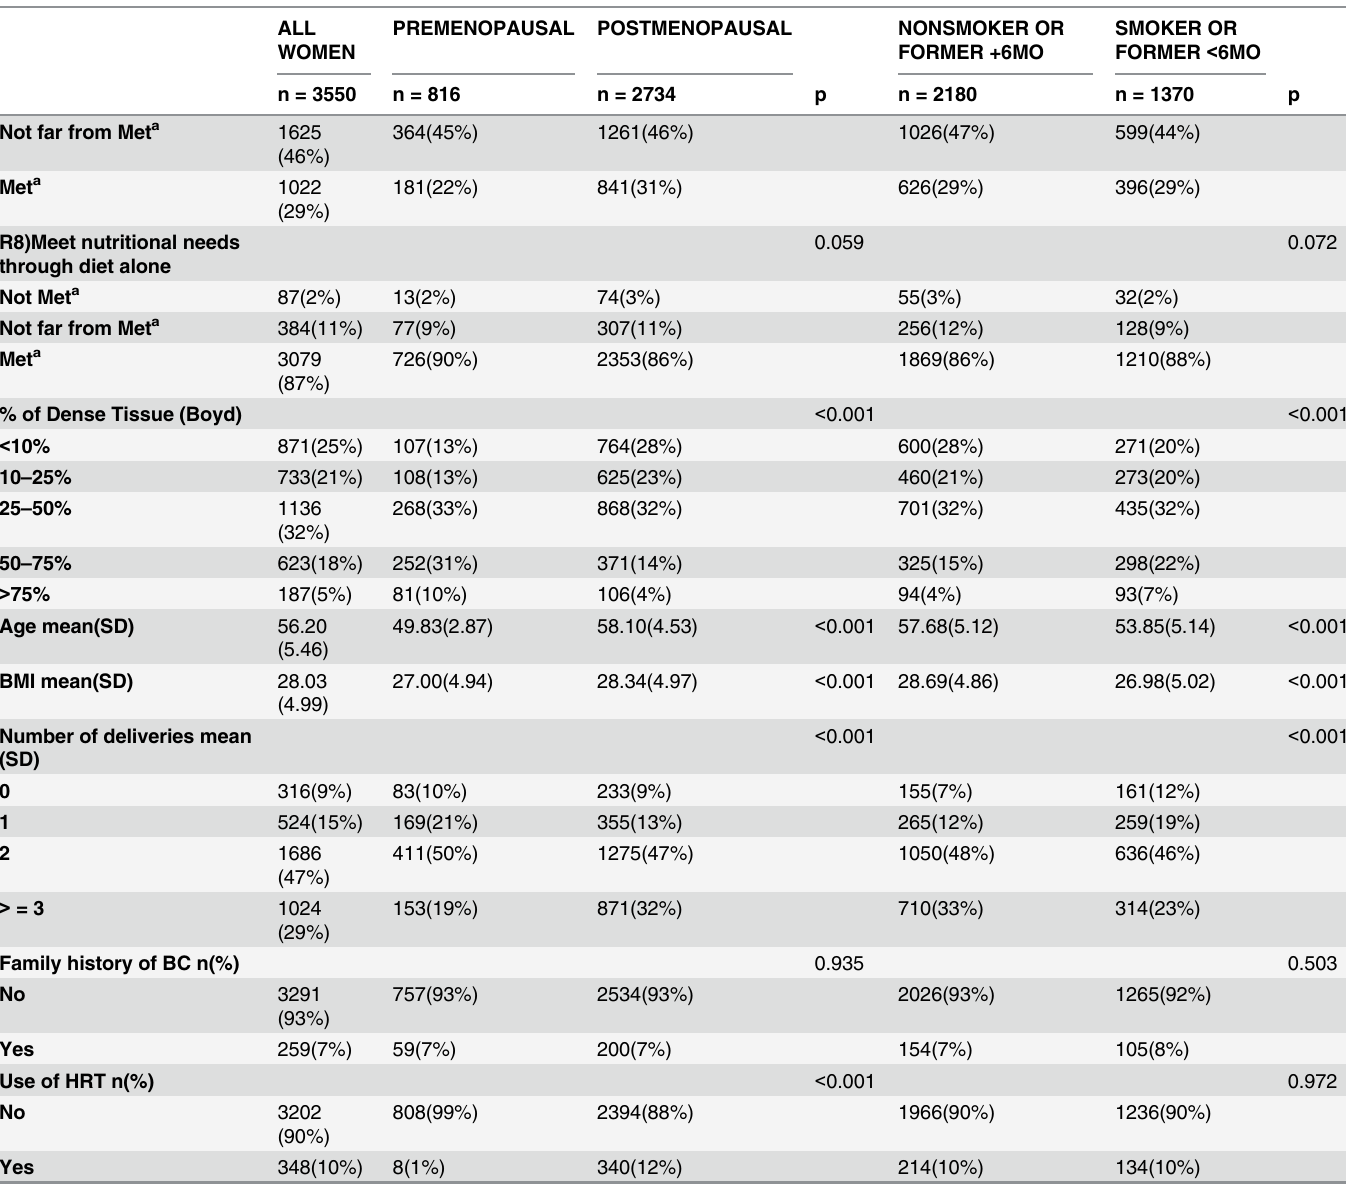
revealed that an adequate body fatness throughout life (OR = 0.84; 95%CI = 0.70;1.00) and a moderate consumption of high density foods (OR = 0.75; 95%CI = 0.56;1.01) seem to be mar- ginally associated with a reduced MD, especially in postmenopausal women (OR = 0.84; 95% CI = 0.69;1.03 and OR = 0.71; 95%CI = 0.51;0.99 respectively) for which avoiding excessive alcohol consumption also appeared to be an important factor (OR = 0.80; 95%CI =